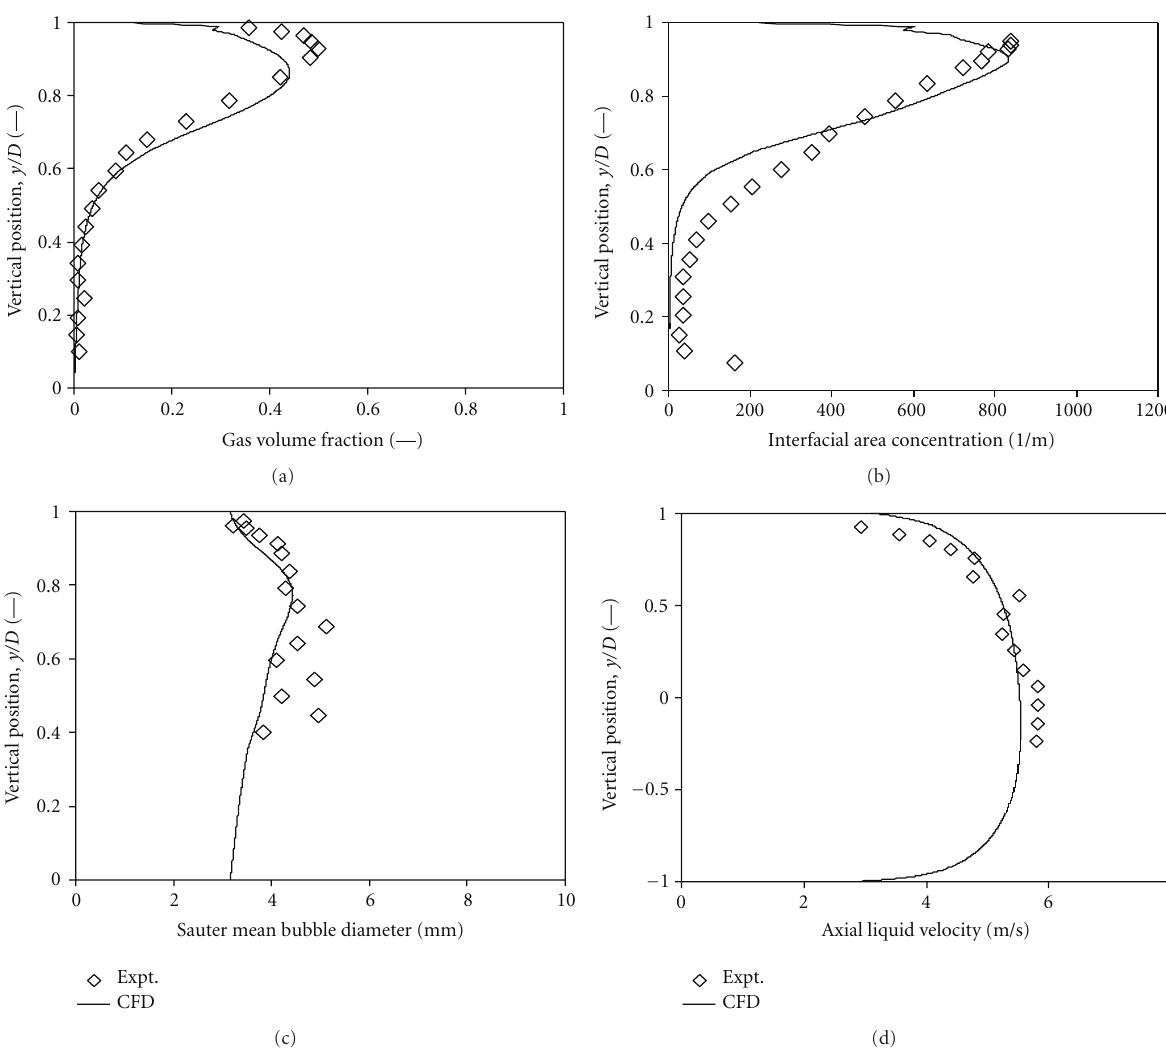
Figure 8: Comparison of predicted and experimental data of Kocamustafaogullari and Wang [17] for superficial gas velocity of 0.51 m/s, superficial liquid velocity of 4.4 m/s, and volume fraction of 0.102; (a) gas volume fraction, (b) interfacial area concentration, (c) Sauter mean bubble diameter, and (d) axial liquid